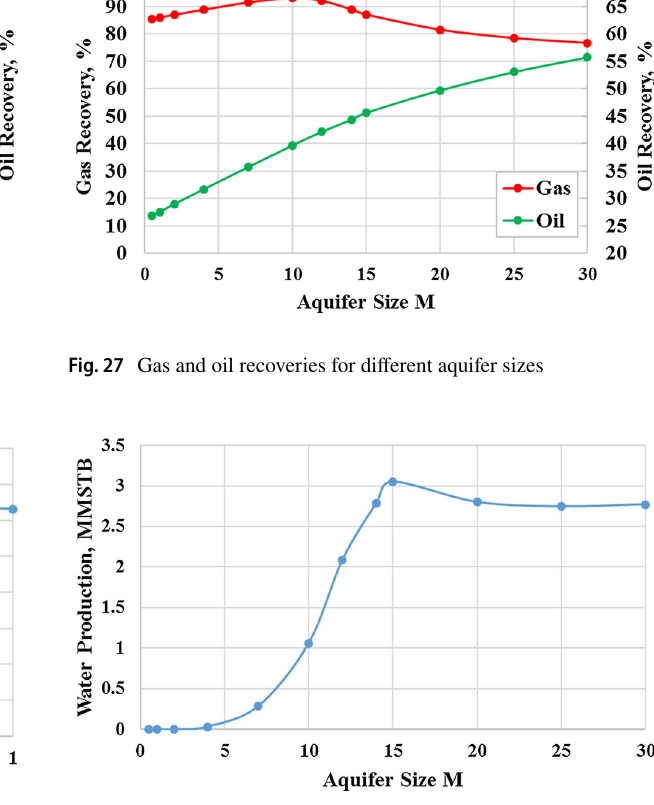
Fig. 25 Total water production for different completion lengths